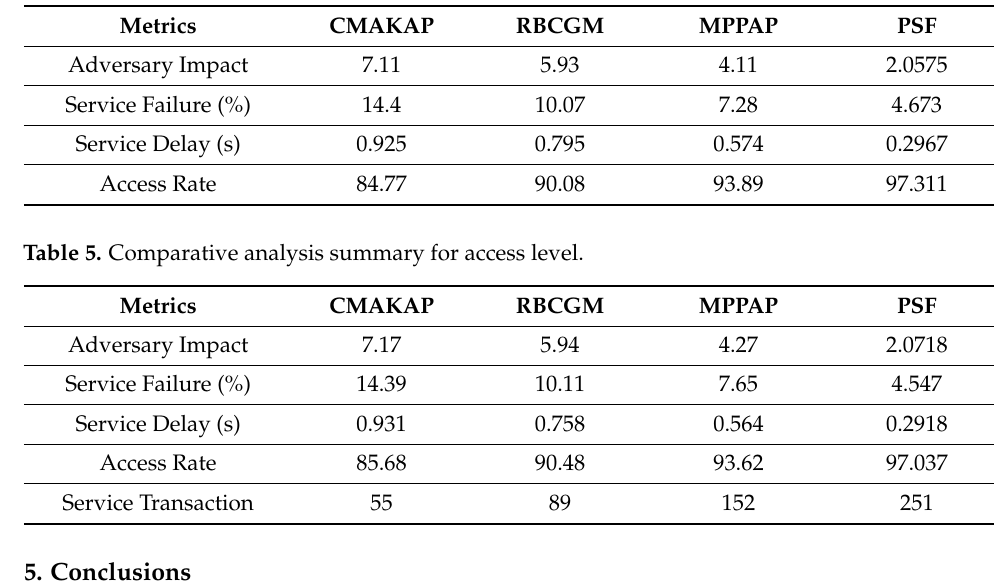
Figure 11. Service transaction analysis. Table 4. Comparative analysis summary for transactions.